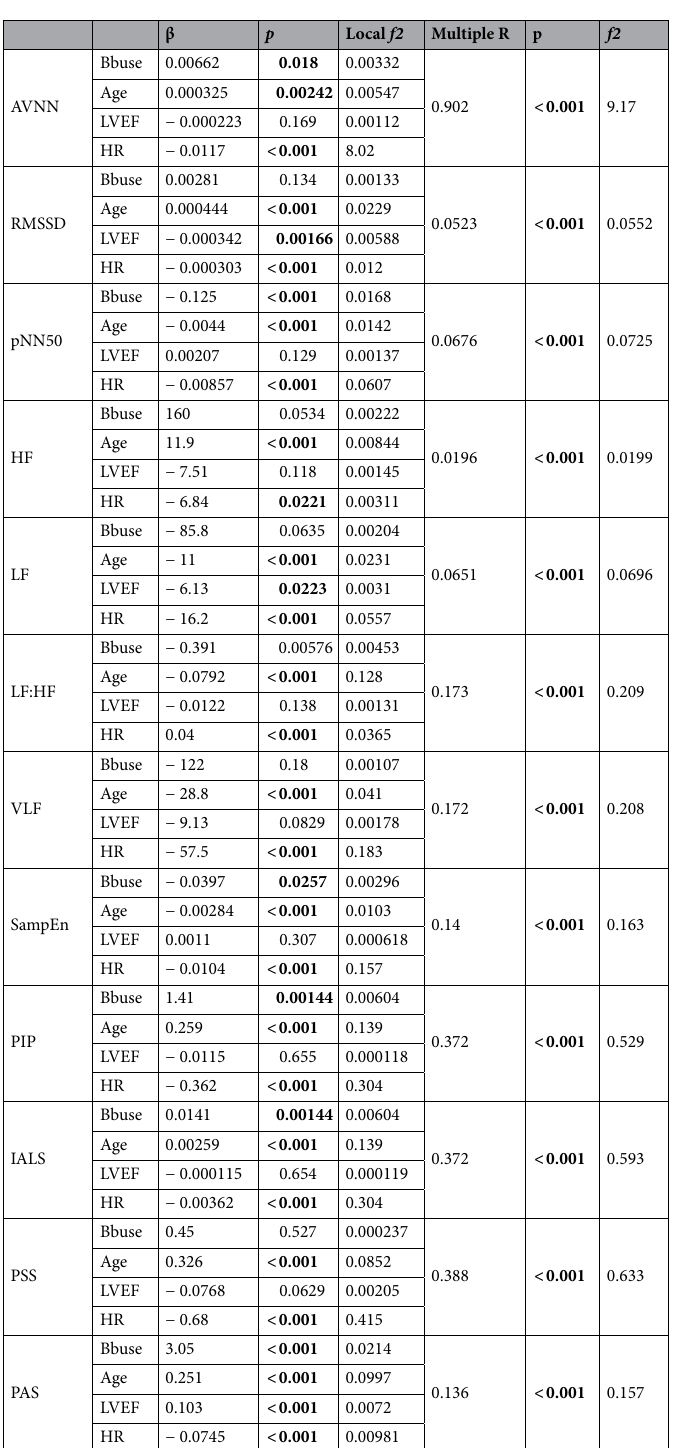
Table 4. Multivariate linear regression model of the relation between BB therapy and standard heart rate variability features in preserved ejection fraction (HFpEF). Bbuse beta-blocker use (bold p values are